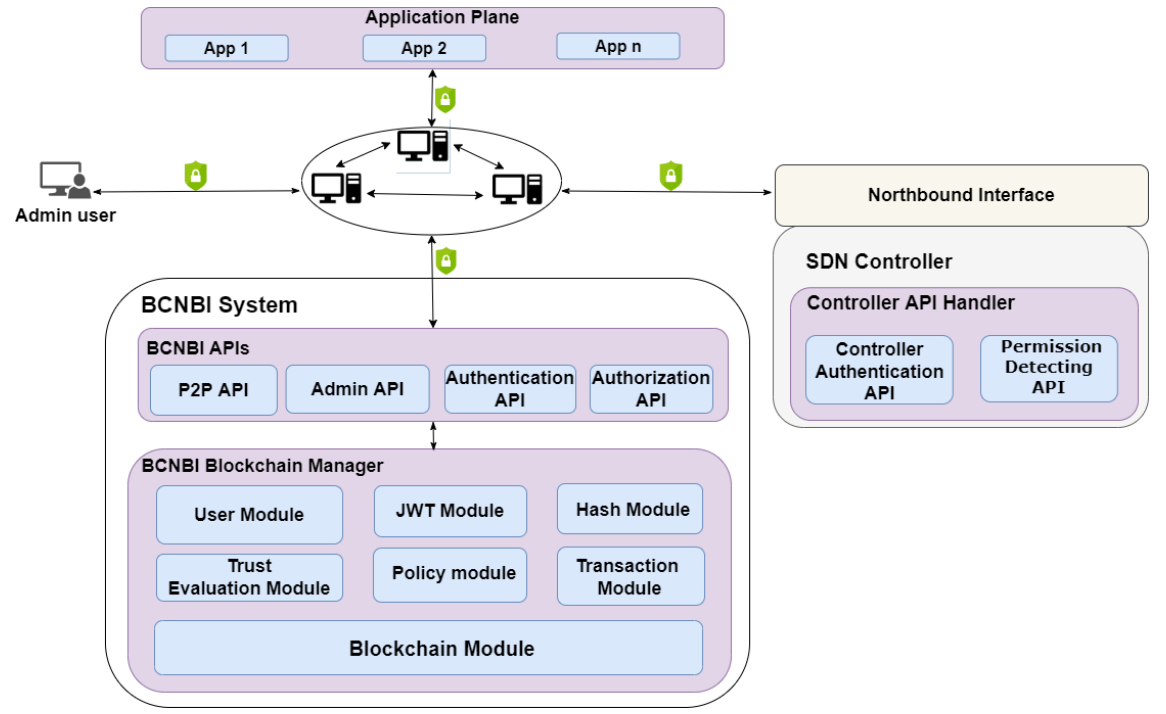
Figure 2. The high-level architecture of the proposed solution.